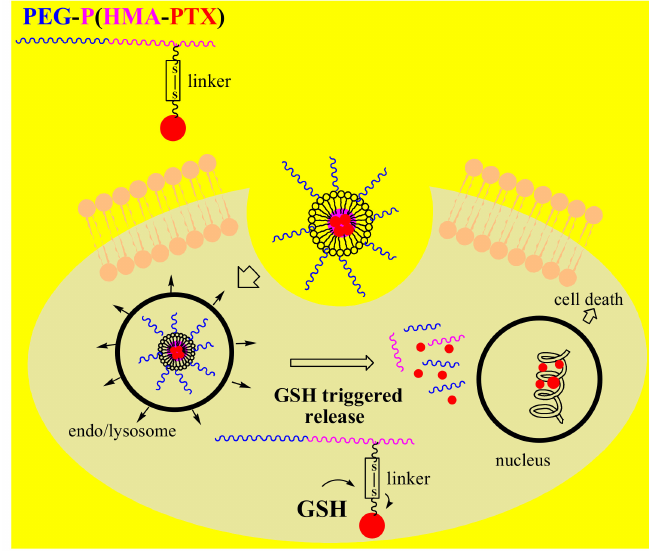
Figure 4. Mechanism of action of redox-responsive polymernanoparticles (NPs) with bonded drug PTX via a disulfide linker to diblock copolymerPoly(ethylene glycol)-b-poly(2-hydroxyethyl